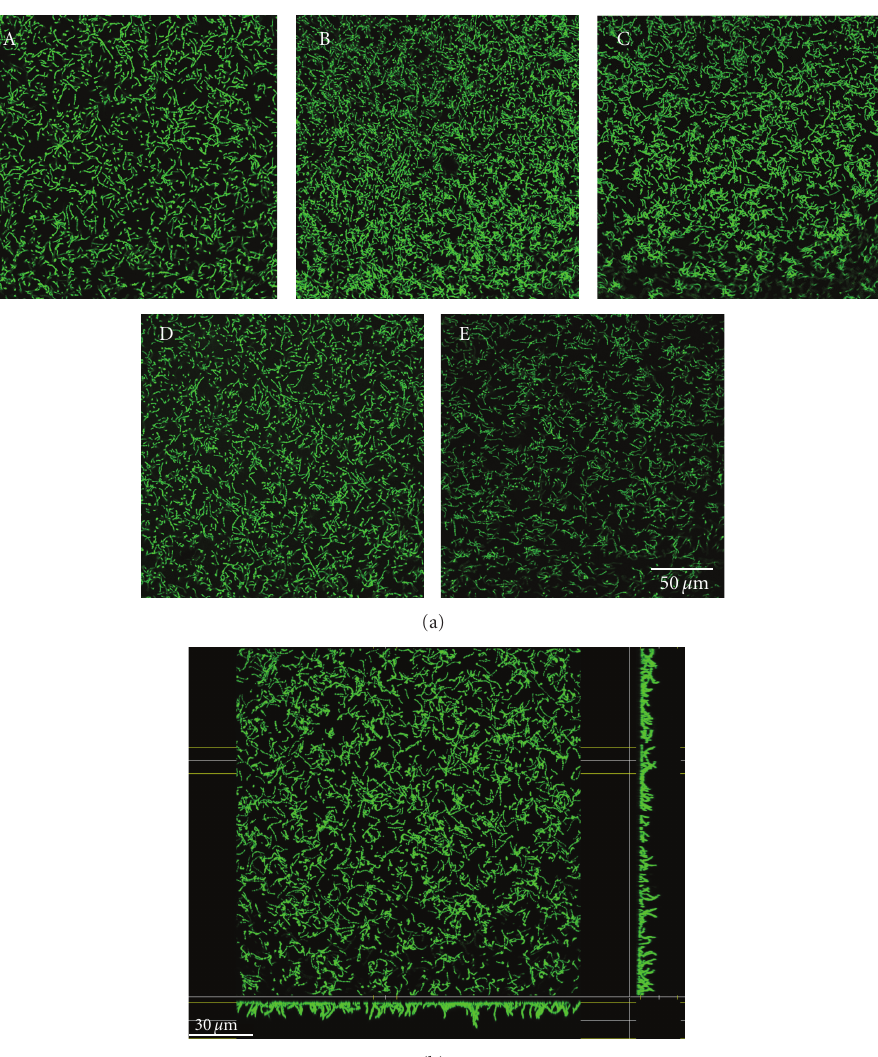
Figure 10: (a) Streptococcus sanguinis cultured on glass coated with nonhexylated polymer (A), glass coated with hexylated polymer (B), glass coated with hexylated polymer and spin coated with amorphous silicon dioxide (C), glass coated with hexylated polymer and spin coated with nanoporous silicon dioxide (D), and untreated glass (E). (b) Noticeable bacterial adhesion of Streptococcus sanguinis on the border of glass coated with hexylated polymer and spin coated with amorphous silicon dioxide